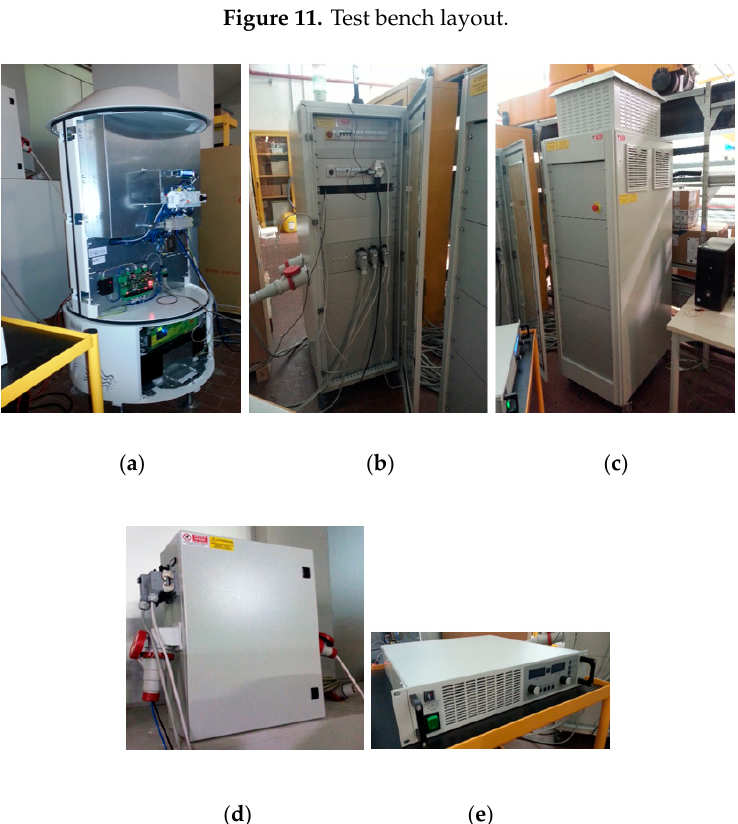
Figure 12. Devices of the test bench: ( a ) BESS, ( b ) CompactRio controller, ( c ) resistive load, ( d ) portable measurement device, ( e ) DC power supply.